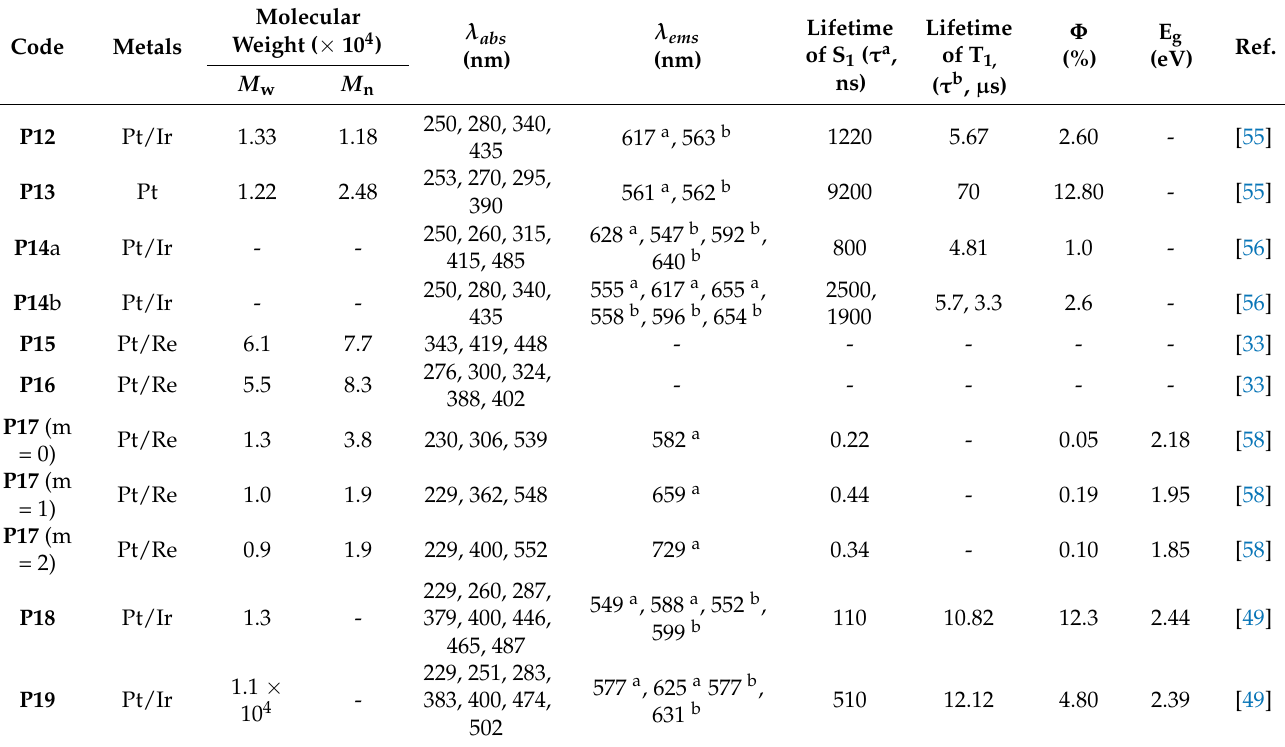
Table 3. Photoluminescence (PL) data of selected heterometallic poly(metalla-ynes) P12–P19